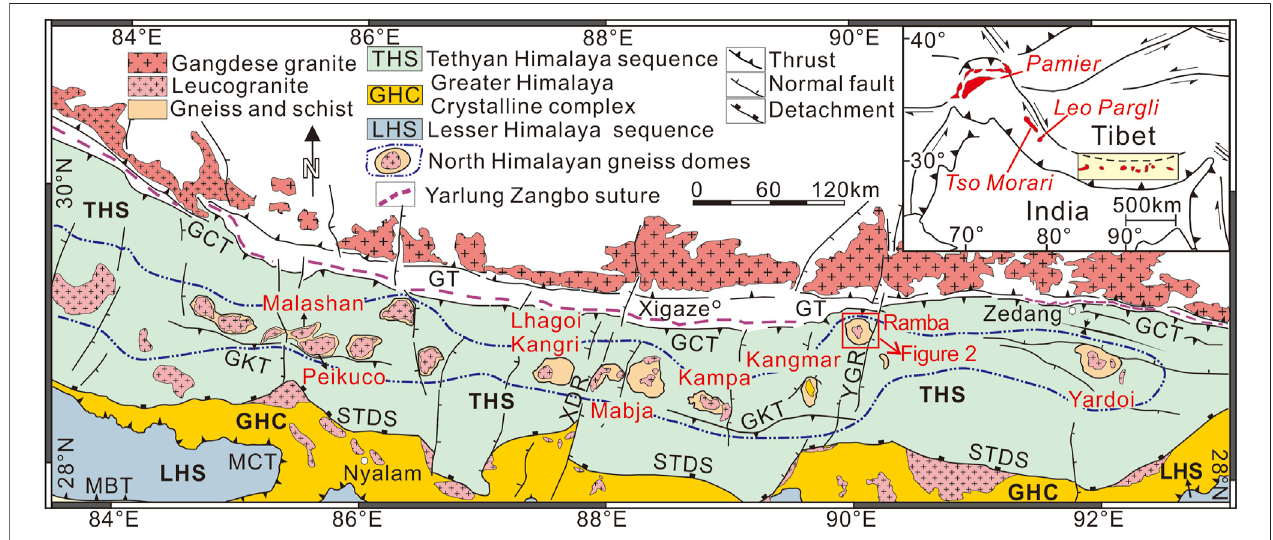
FIGURE 1 | Generalized geological map of the Himalayan orogen (modi fi ed from Wang et al., 2018). Abbreviations of metamorphic complexes: GT, Gangdese thrust; GCT, Greater Counter thrust; GKT, Gyirong – Kangmar thrust; STDS, south Tibetan detachment system; MCT, main central thrust; MBT, main boundary thrust.